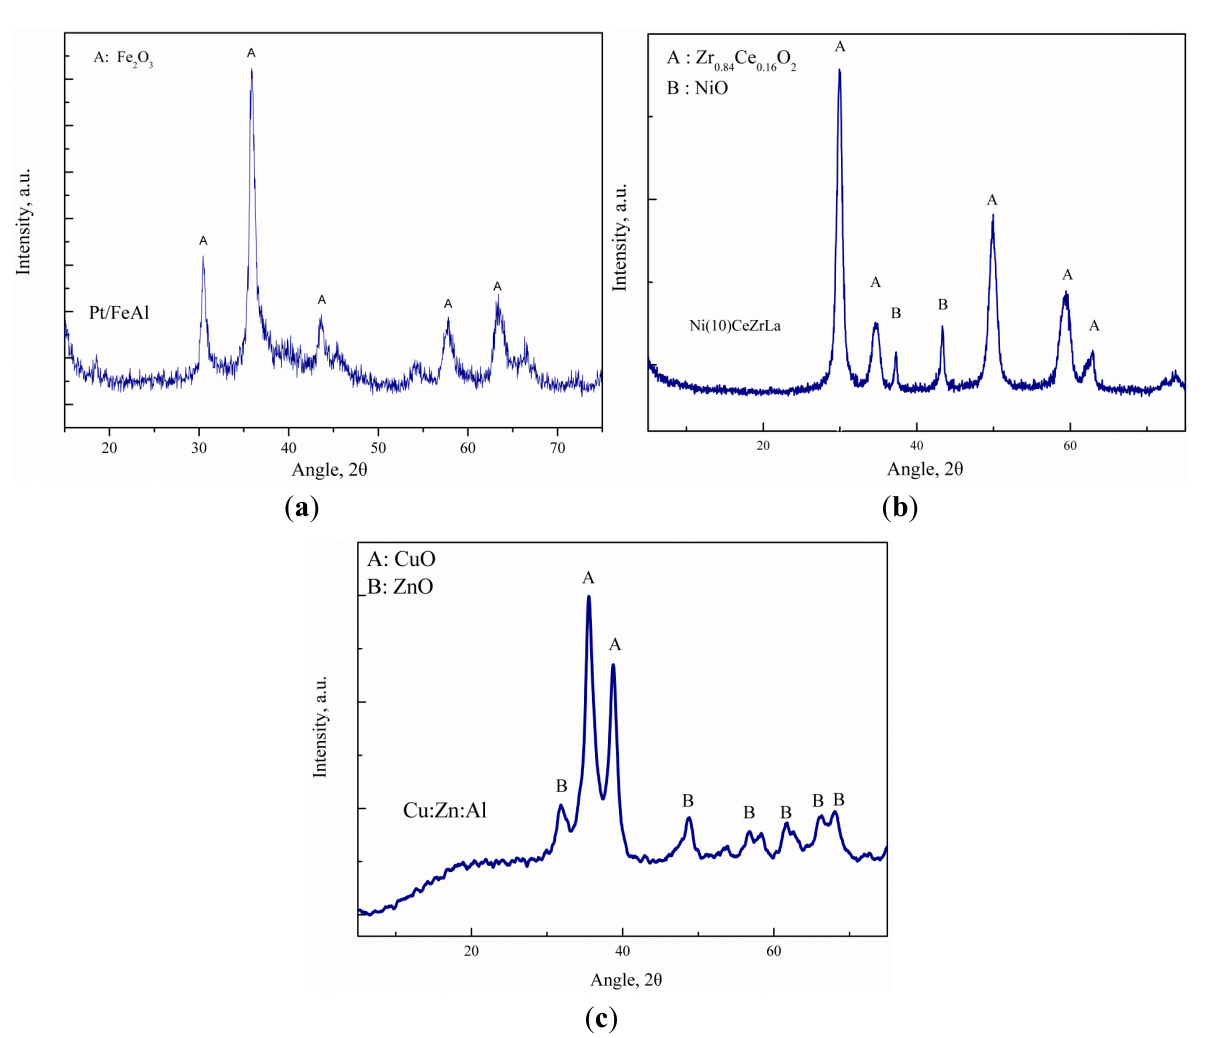
Figure 1. XRD patterns of ( a ) Pt/FeAl, ( b ) Ni/CeZrLa and ( c ) Cu:Zn:Al